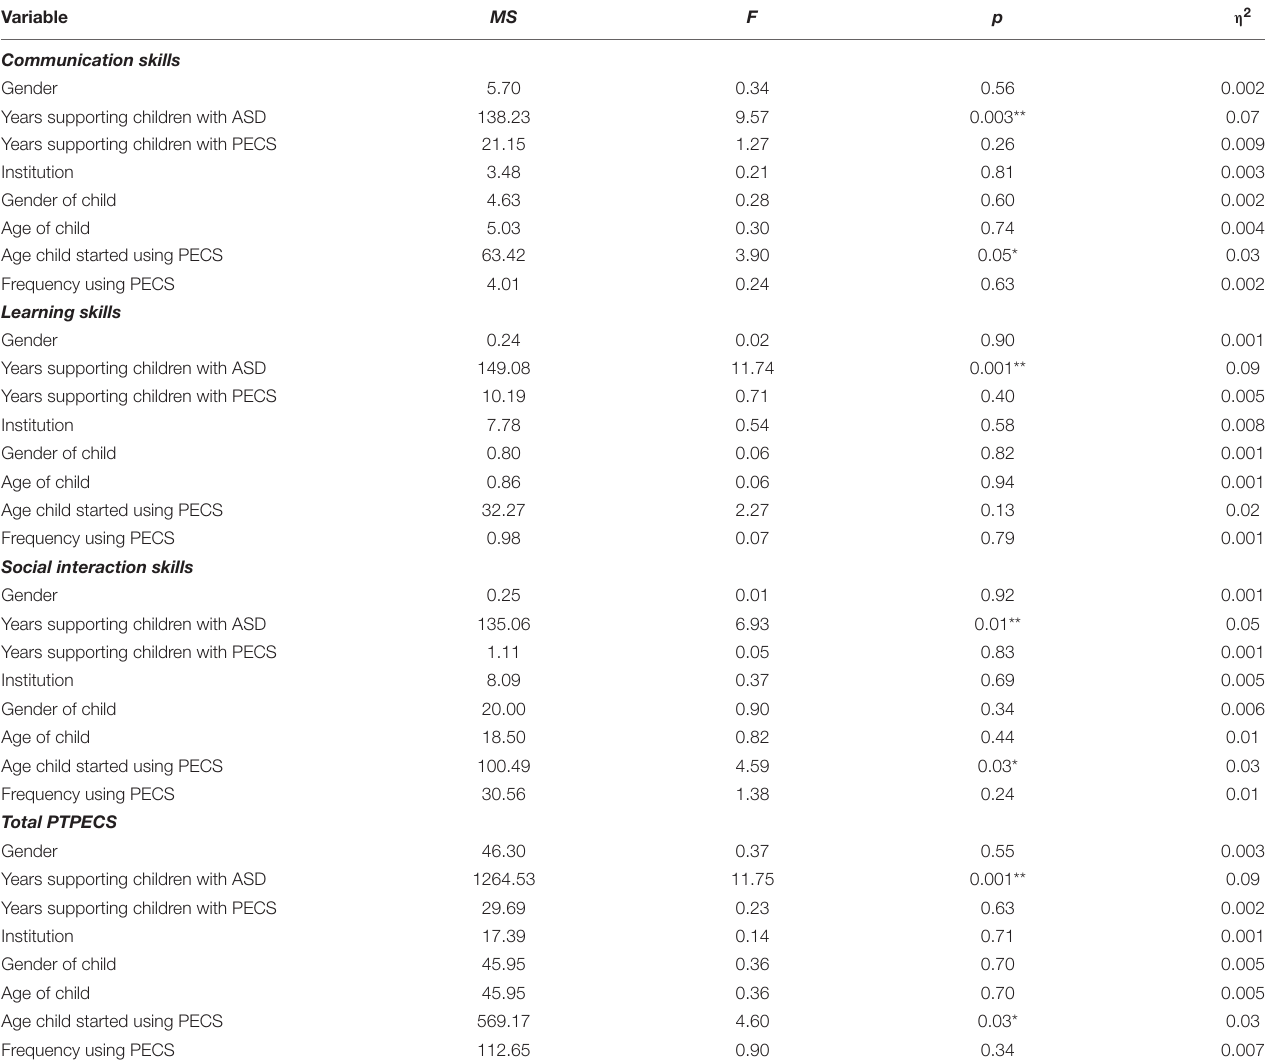
TABLE 4 | Two-way analyses of variance for participant type, other demographics, and perception. Variable MS F p η